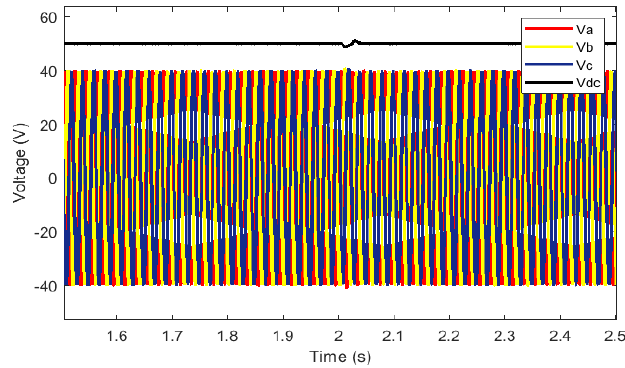
Figure 12. Islanded mode PCC and DC bus voltage value.